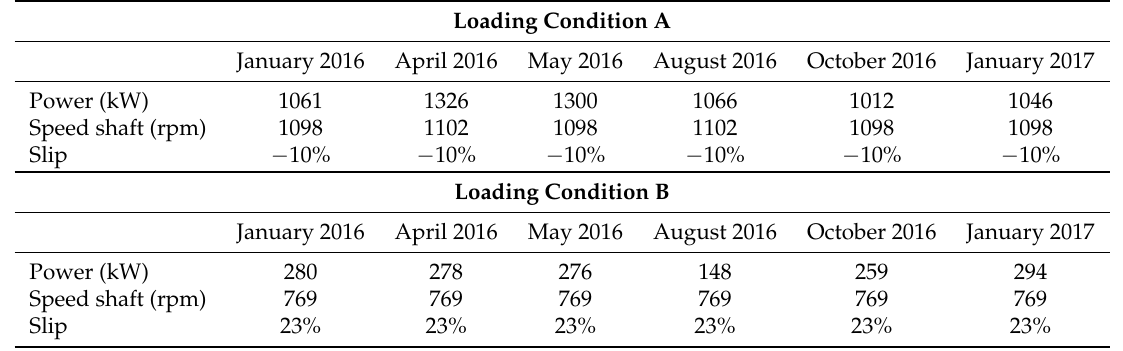
Table 2. WT operating conditions for each measurement of the spectral analysis.